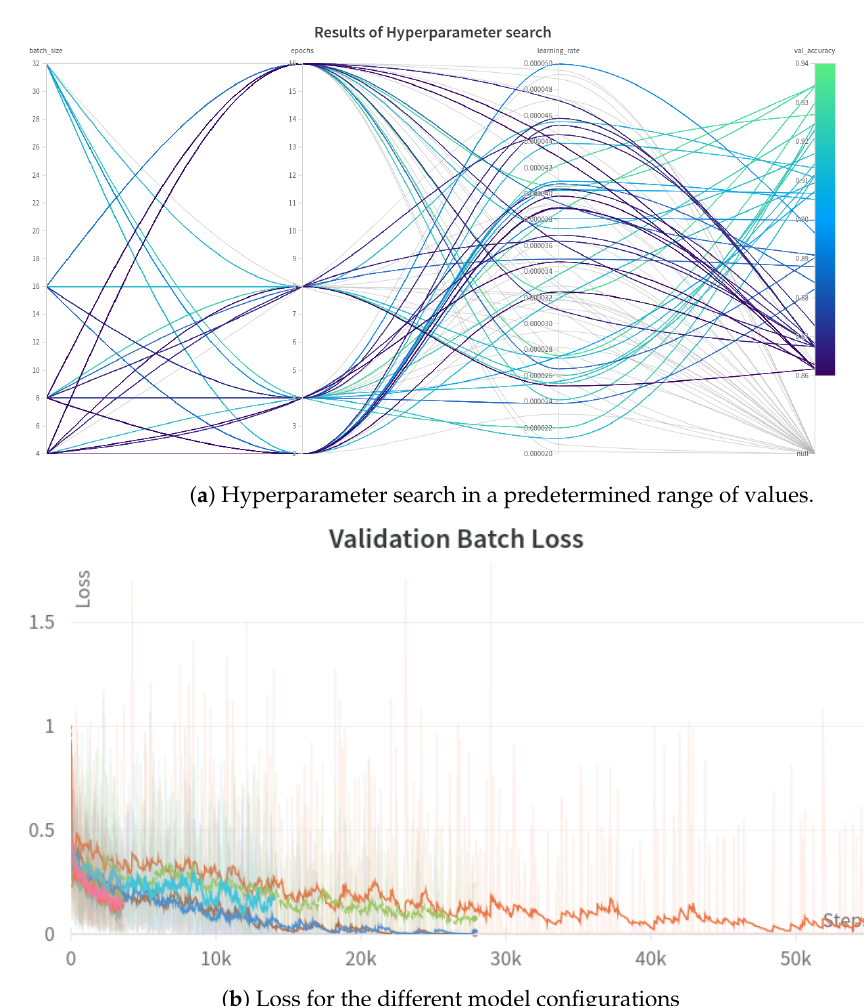
Figure 3. Hyperparameter search and validation